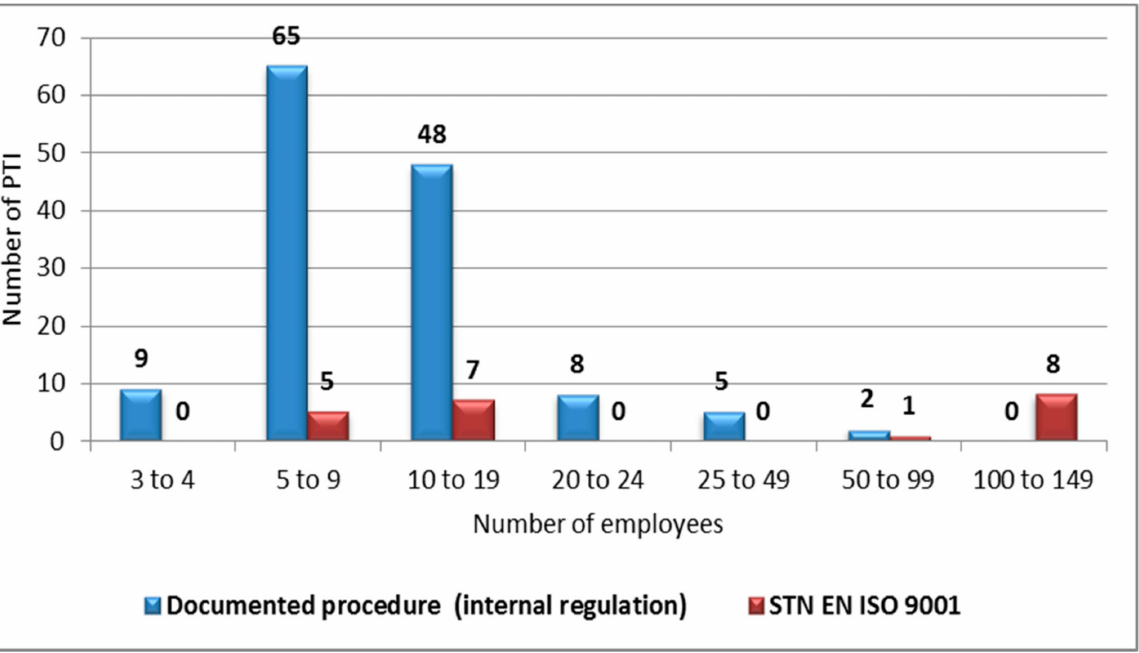
Figure 1. Number of companies operating PTIs by number of employees and fulfilment of quality management requirements. Source: Author according to